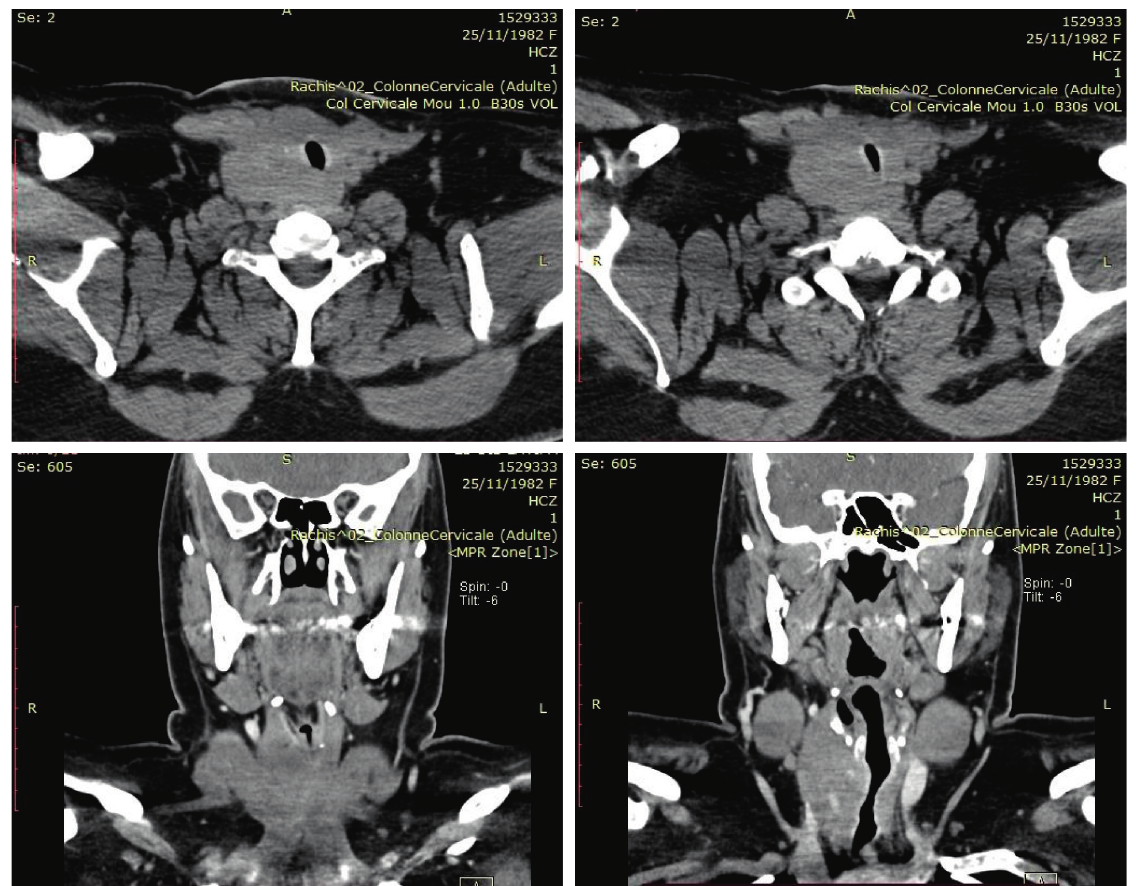
Figure 2: CT image in transverse and coronal sections showing a large goiter with tracheal deviation and